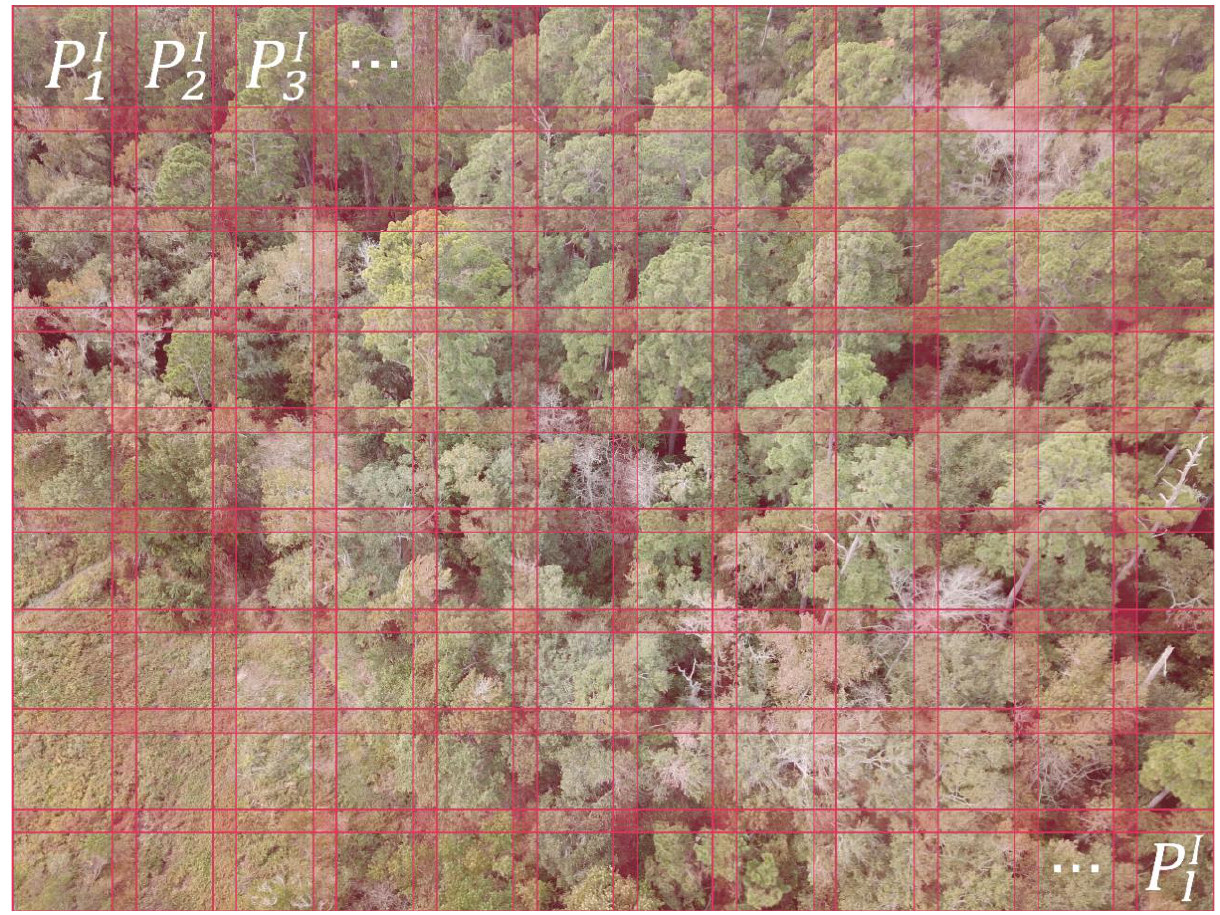
Figure 6. A visualization of the SAHI process. An image with a resolution of 4000 × 3000 pixels is processed one slice at a time, iteratively from 𝑃 1𝐼 , 𝑃 2𝐼 ,𝑃 3𝐼 , … , 𝑃 𝑙𝐼 . The dimensions of each slice are 640 × 640 pixels — the slice dimension should match the computer vision model input dimensions for ideal performance. Each time a slice is inferenced, the next slice is offset at 20% overlap. This creates areas of an image that are re-inferenced by SAHI and allows for cavities to be detected across several tiles.